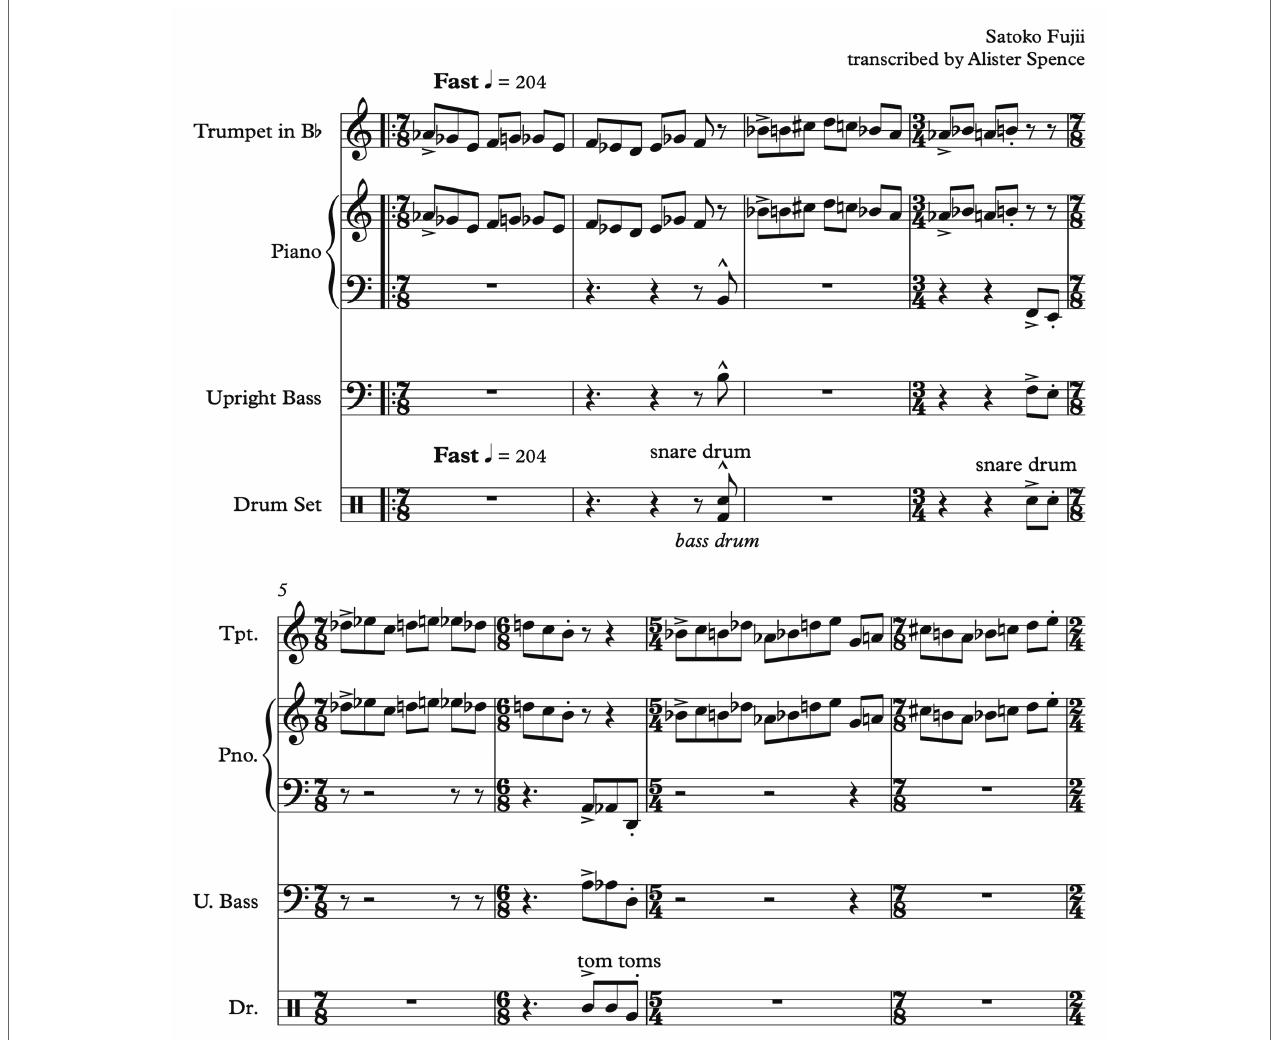
FIGURE 2 | “Spiral Staircase” melody excerpt (full